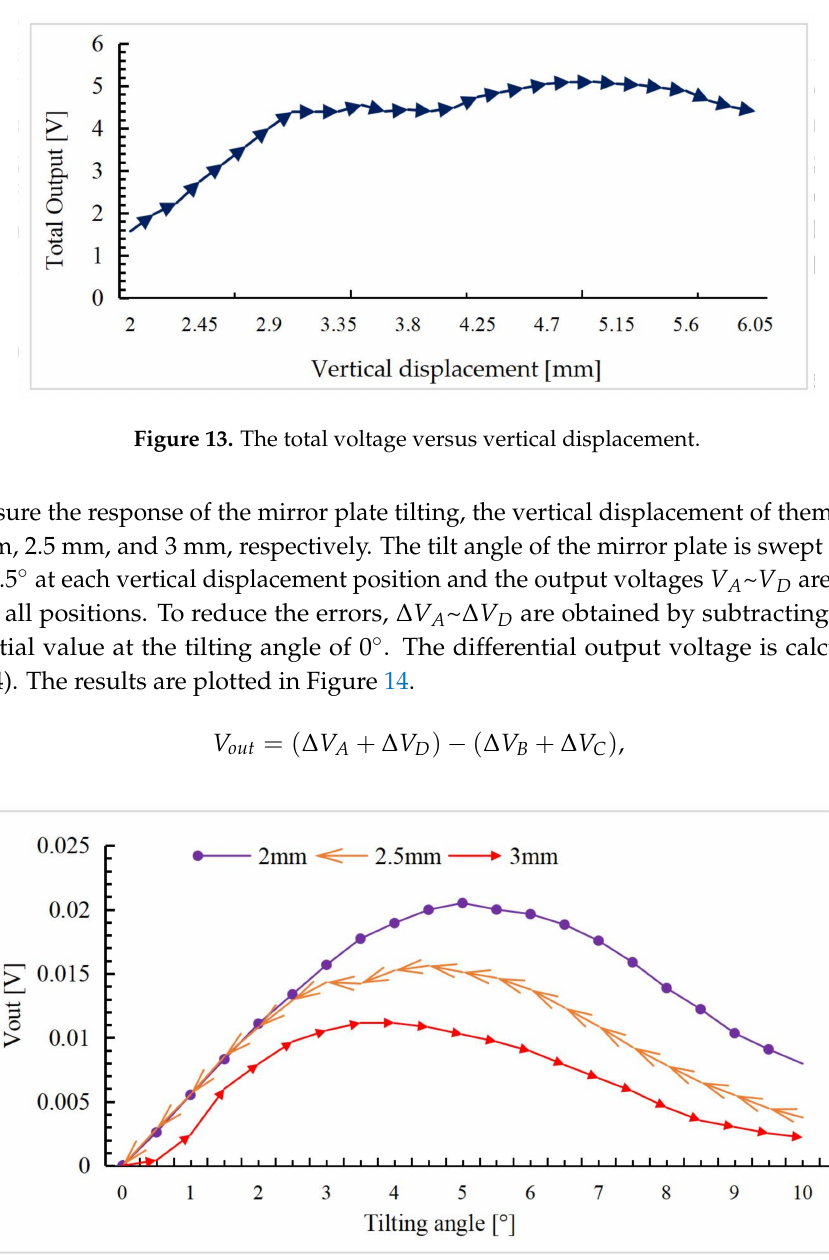
Figure 14. The differential output voltage versus the tilting